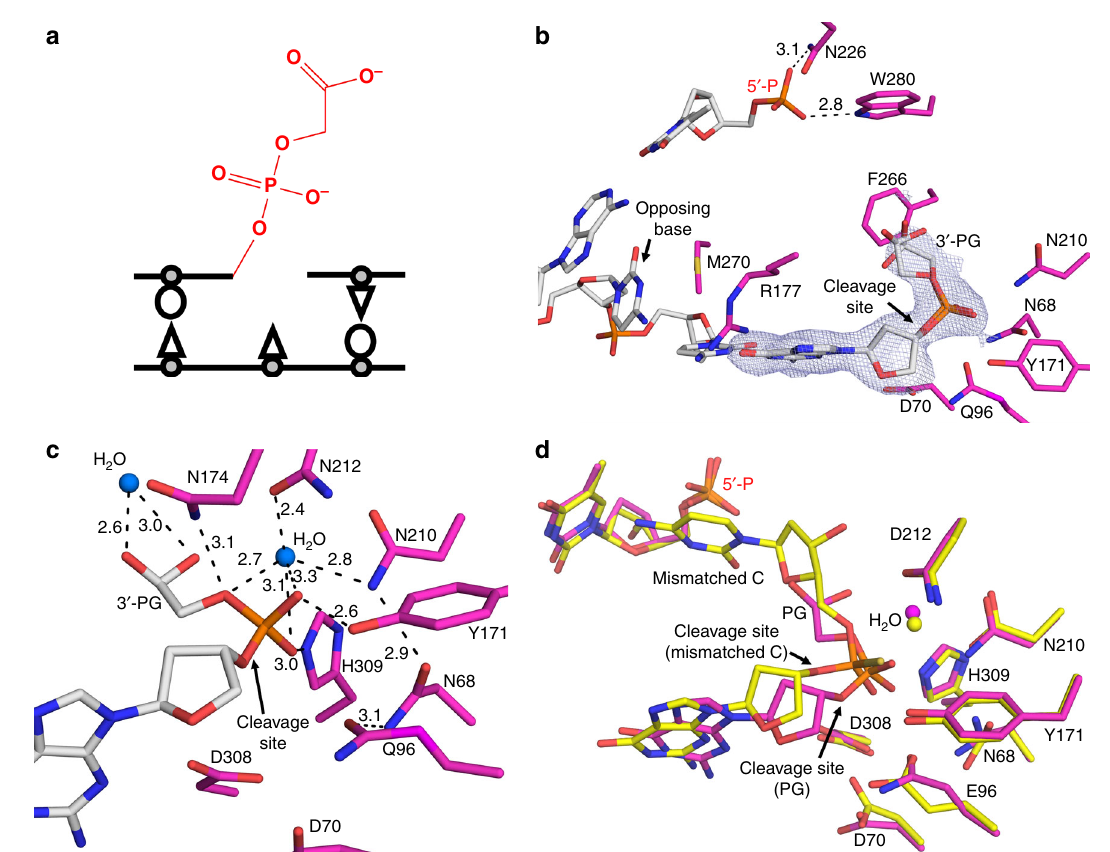
Fig. 5 Structure of APE1 poised to remove a 3 ʹ -PG. a Schematic showing the structure of PG at the 3 ʹ end of a DNA nick at neutral pH. b APE1 exo 3 ʹ -PG substrate complex. 2 F o – F c map density (1 σ ) is shown in light blue. The two 3 ʹ -PG conformations are shown. c A close-up of the APE1 3 ʹ -PG substrate complex active site. The protein side chains are shown in magenta and DNA residues in gray. Waters are shown as blue spheres and key residues, the site of cleavage, and distances (Å) are indicated. d An overlay of the 3 ʹ -PG (magenta) substrate complex with the 3 ʹ mismatched (yellow) substrate